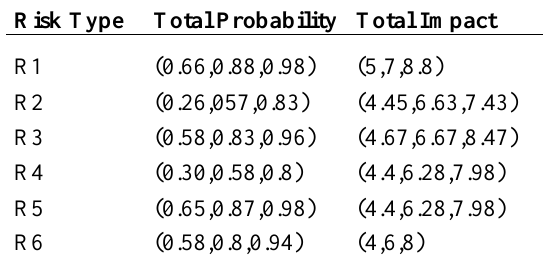
Table 6. Calculated total probabilities and impacts for each risk.